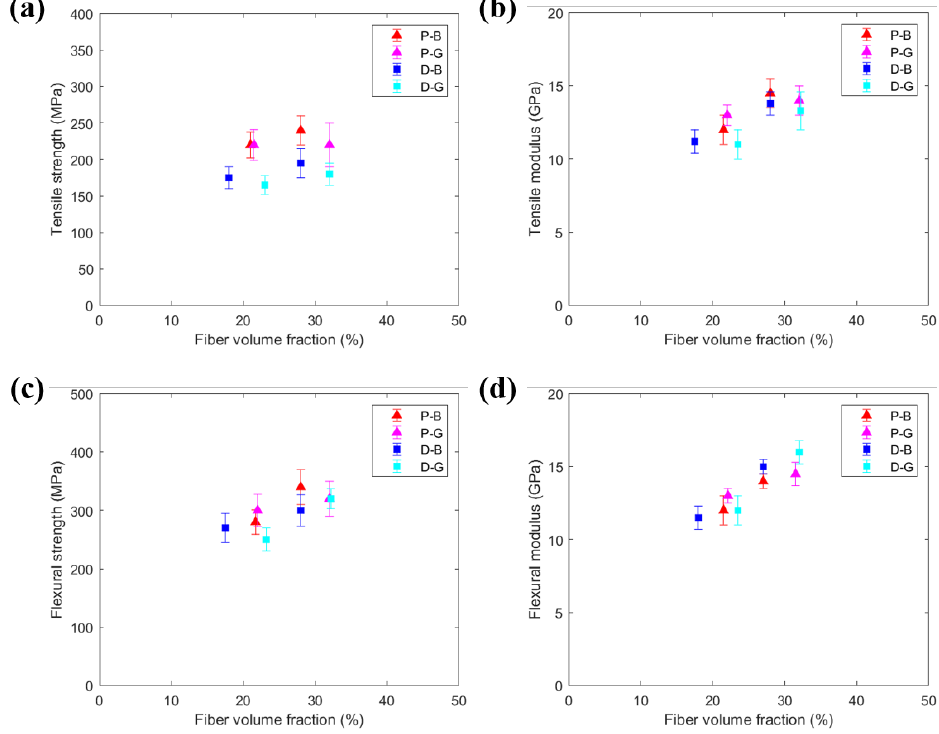
Figure 7. Scatter diagrams of the tensile and flexural properties of the GF/PA6 specimens by fiber volume fraction: ( a ) tensile strength; ( b ) tensile modulus; ( c ) flexural strength; ( d ) flexural modulus.